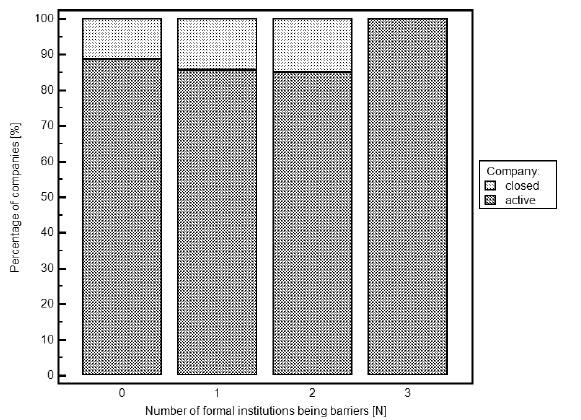
Figure 1. Number of formal institutions pointed out by managers as obstacles to the development of their companies (source: own elaboration)